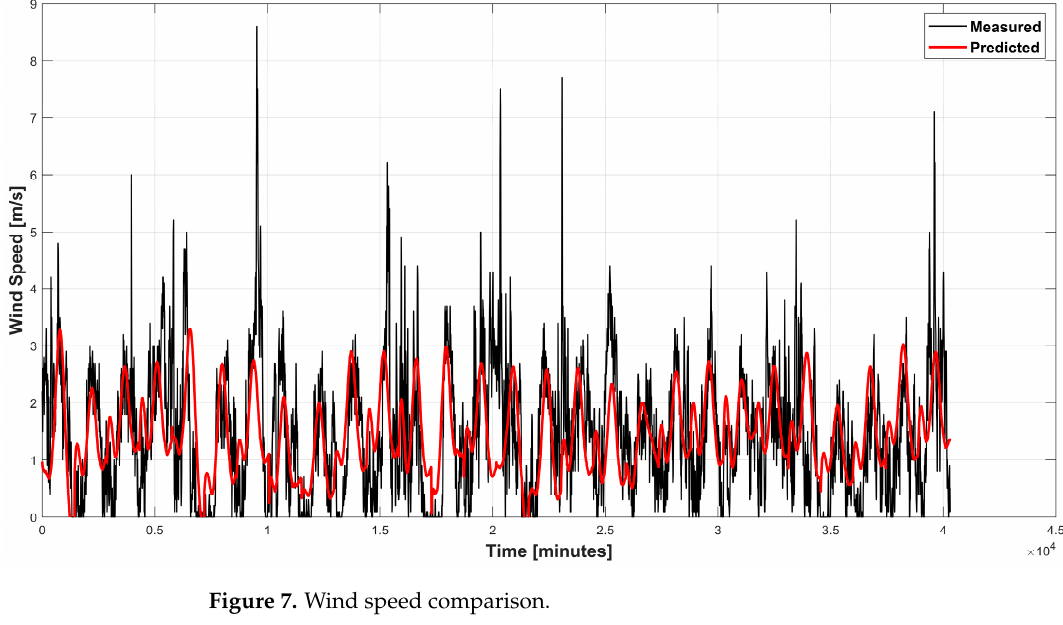
Figure 7. Wind speed comparison.